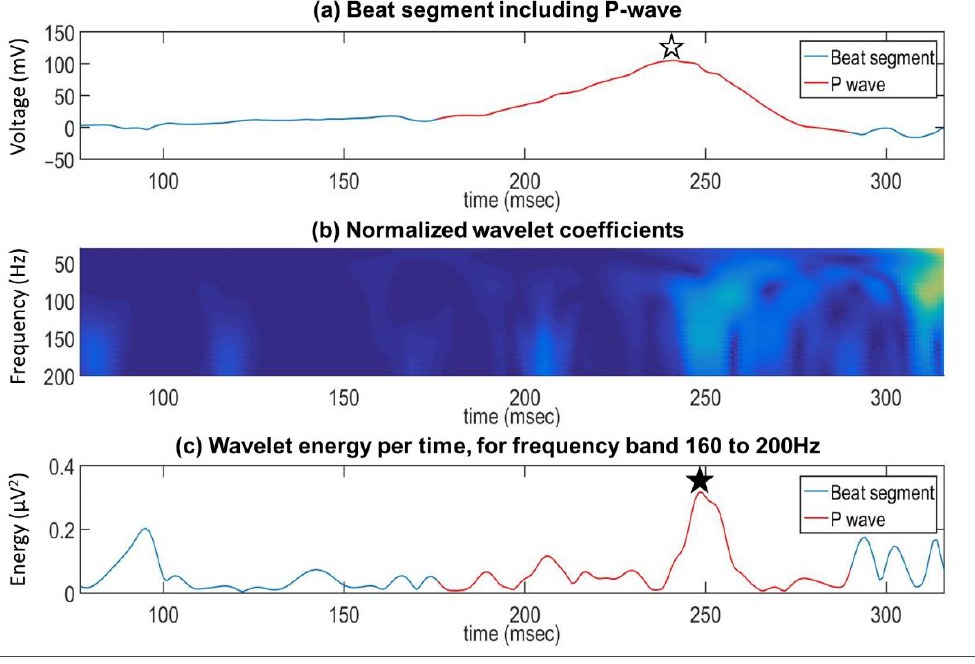
Figure A9. Example of wavelet analysis of an ECG signal: ( a ) ECG signal window of 250 ms preceding QRS complex. P-wave is depicted in red; ( b ) spectrogram of the same signal; ( c ) wavelet energy per time, for the high-frequency band. The white asterisk in panel ( a ) denotes the P-wave peak, while the black asterisk in panel ( c ) indicates maximum energy for this frequency zone.